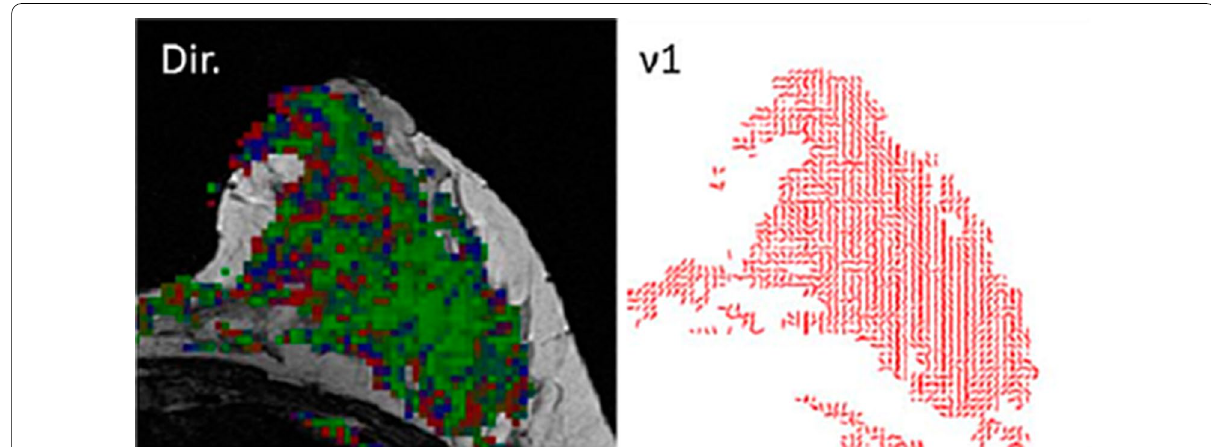
Fig. 3 Characterization of the lactating breast using DTI. DTI‑derived direction and vector maps of a 30‑year‑old healthy lactating volunteer are presented. Axial images overlaid on anatomical non‑fat surpassed T2‑weighted images at the height of the nipple are present. The direction map represents the direction of the 1st principal eigenvector in a three color code: red: right <<>> left; green: head <<>> feet; blue: anterior <<>> posterior. The vector map presents in red sticks the direction of the 1st principal eigenvector ν1. Note: The lactating breast exhibits dominant directional diffusion along the anterior–posterior axis, reflecting the structure of milk ducts heading from the base of the breast towards the nipple, while the vector map portray linear successive “duct‑like” structures towards the nipple. Adopted from Nissan et al. Proc. Intl. Soc. Mag. Reson. Med. 22